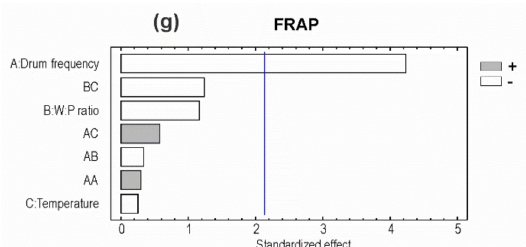
Figure 3. Standardized statistical e ff ects of the experimental factors on the responses (Pareto charts); ( a ) Moisture content; ( b ) sulforaphane; ( c ) glucoraphanin; ( d ) phenolic compounds; ( e ) ascorbic acid, ( f ) FRSA = free radical scavenging ability and ( g ) FRAP = ferric ion reducing ability; A = drum-rotation frequency; B = water-to-pulp ratio; C = drum